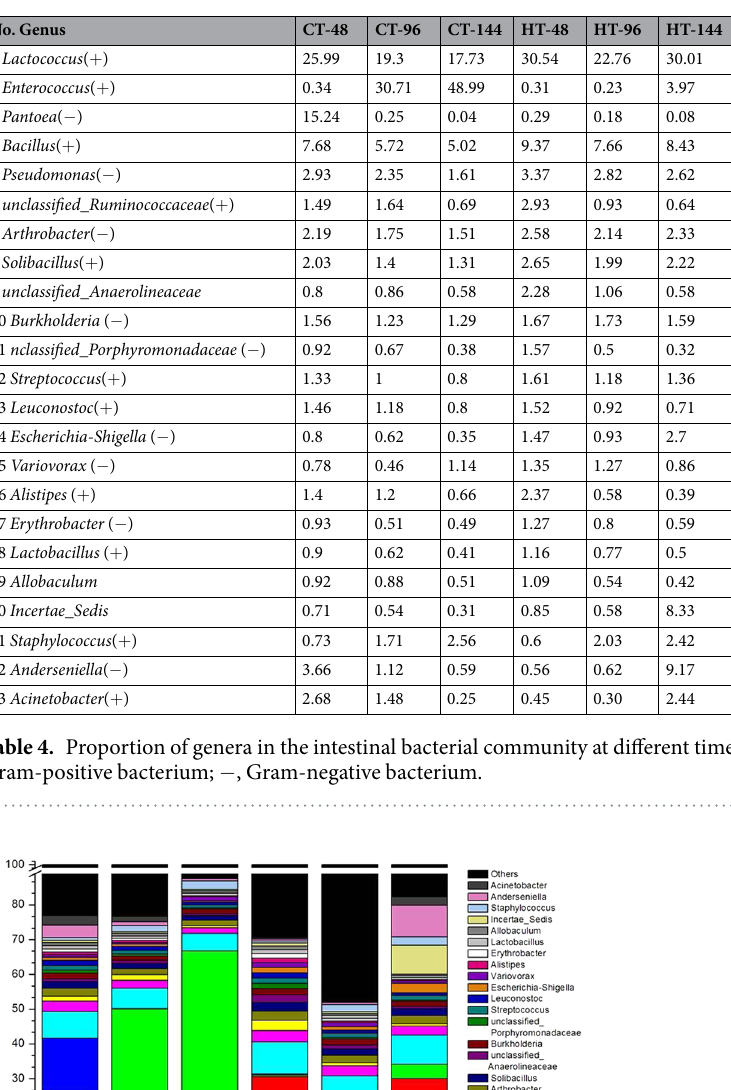
Figure 4. The dominant genera percentage for all samples at each time point. CT/HT-N is sample mentioned in Table